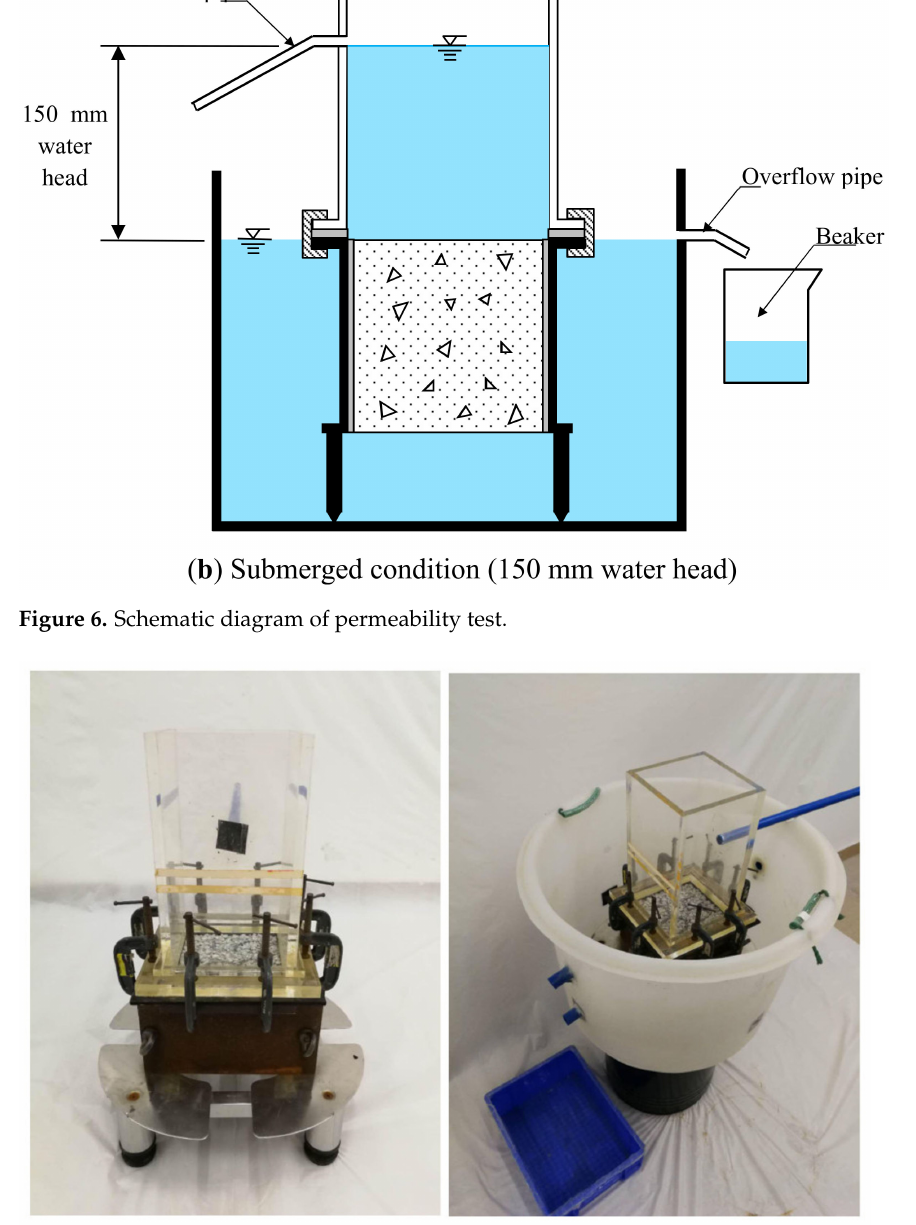
Figure 7. Photograph of permeability